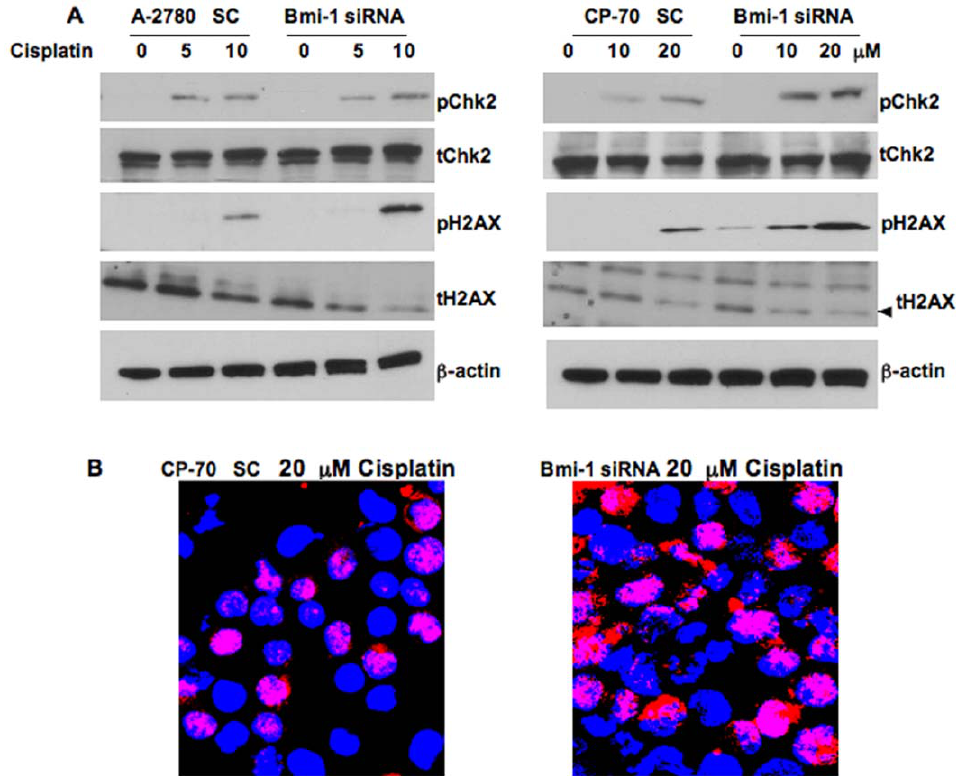
Figure 4. Bmi-1 knockdown augments engagement of the DDR pathway in cisplatin treated ovarian cancer cells. (A) Ovarian cancer cells transfected with scrambled control or Bmi-1 siRNA were treated with or without cisplatin for 48 h. Western blot was performed for phospho Chk-2, total Chk-2, phospho-H2AX, total H2AX and beta actin using respective antibodies. (B) Scrambled control or Bmi-1 siRNA transfected CP-70 cells were subjected to confocal microscopy using 53BP1 antibody (red) and DAPI (blue nuclear staining) to demonstrate nuclear foci formation.